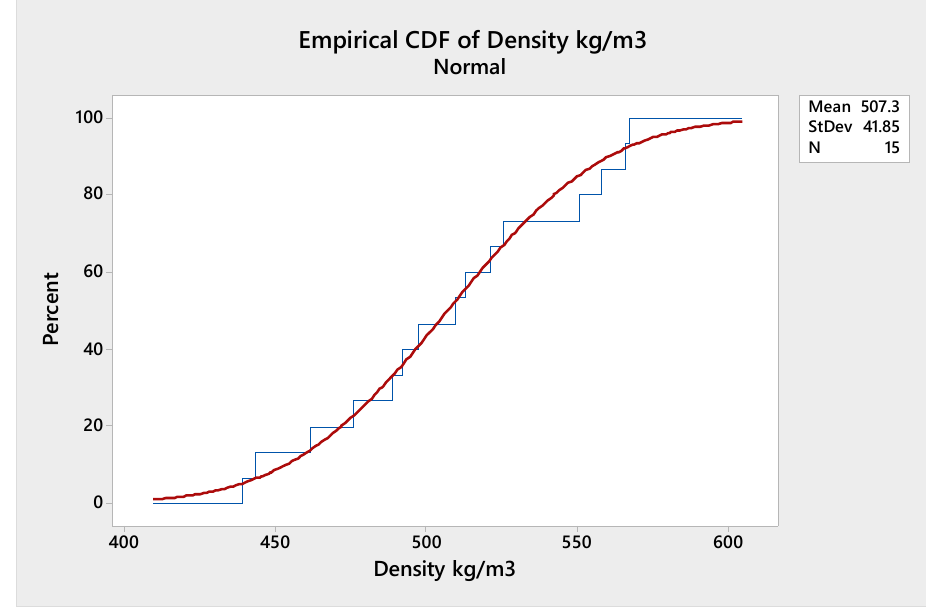
Figure 7. Density of energetic willow stems.